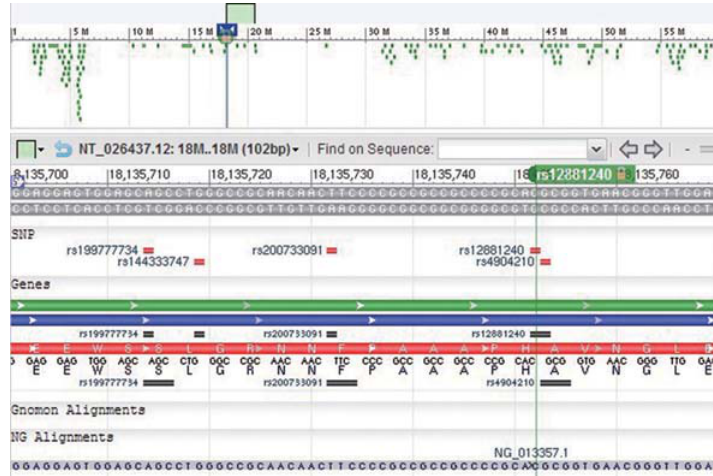
Figure 8- The gene chromatograms of c.717C>T (rs12881240) single nucleotide polymorphisms (SNPs) in PAX9